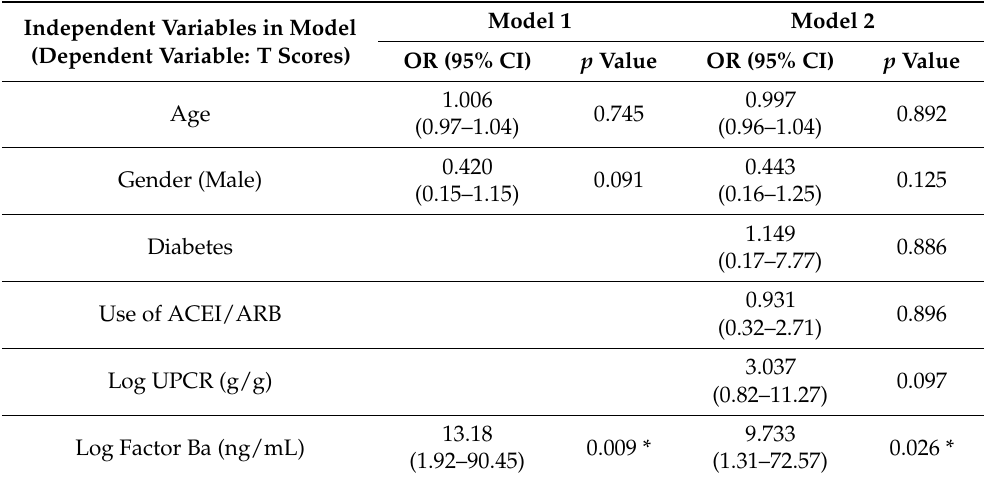
Table 4. Associations between the plasma factor Ba level with tubular atrophy/interstitial fibrosis (the Oxford T scores).